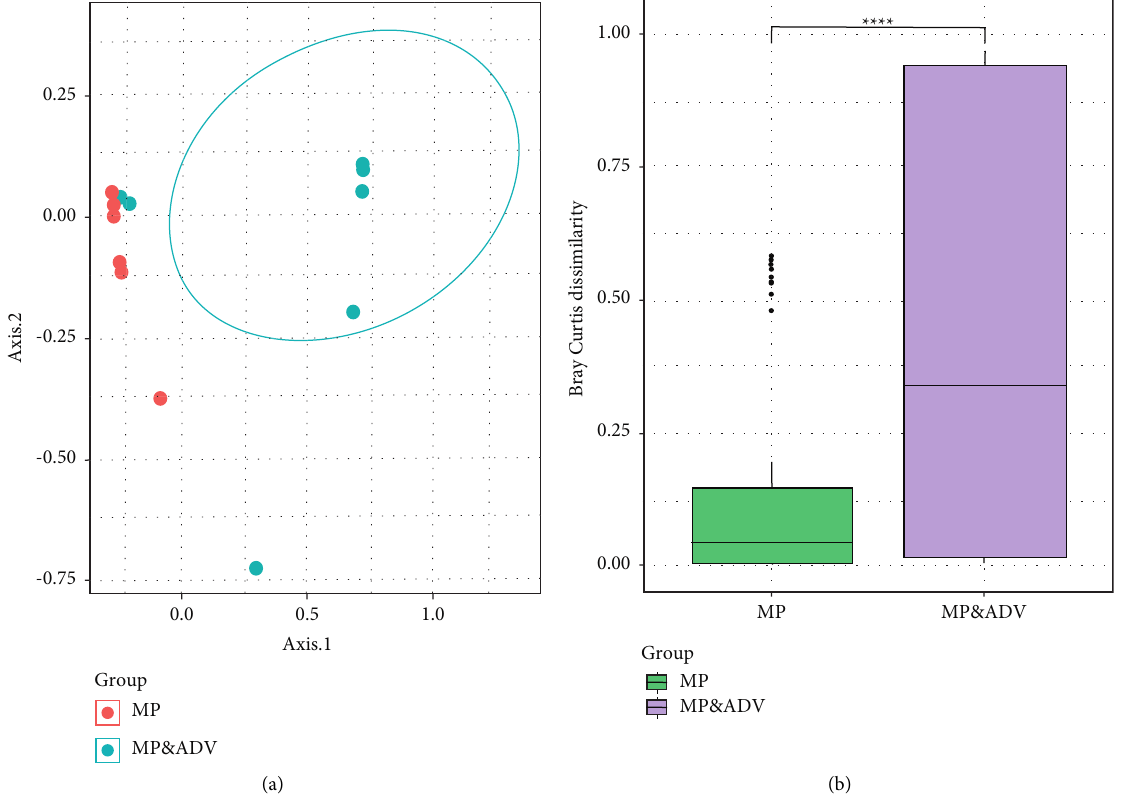
Figure 2: Comparison of the β -diversity of microbial communities between the MP and MP&ADV groups. Each plot represents one community from one patient. (a) PCoA plot based on Bray–Curtis distance. Each plot represents one community from one patient. (b) β -diversity based on the Bray–Curtis distance of two groups. ∗∗∗∗ P < 0 . 001. PERMANOVA, permutational multivariate analysis of